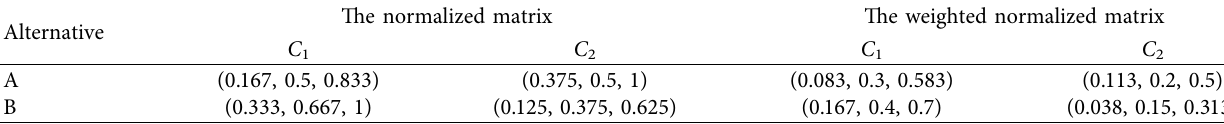
Table 3: Te common steps of Chen’s method and its revised version.